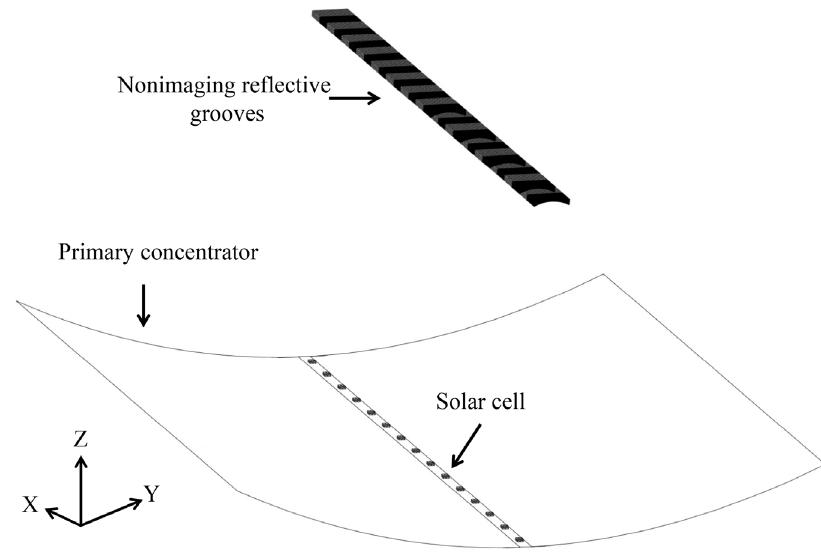
Figure 2. Optical components and their orientation for the HCPV system.